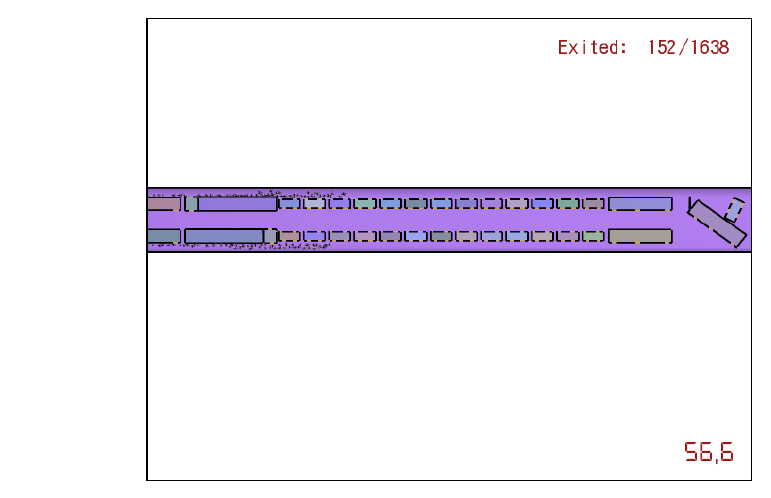
Figure 8 – The simulation example for the noted case after 56.6 seconds from the start of the simulation Рис . 8 – Симуляционный пример приведенного случая спустя 56.6 секунд от начала